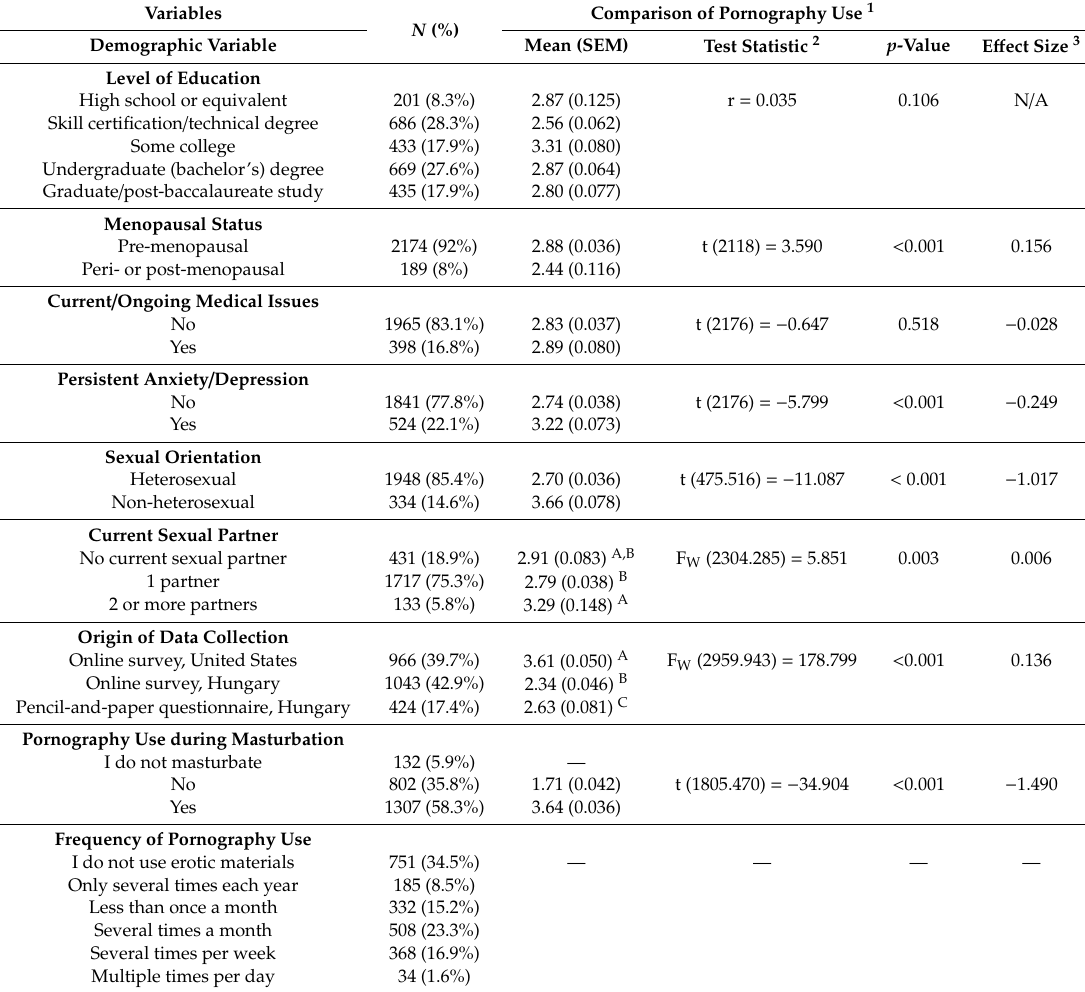
Table 1. Demographic characteristics for participants and their relationship to pornography